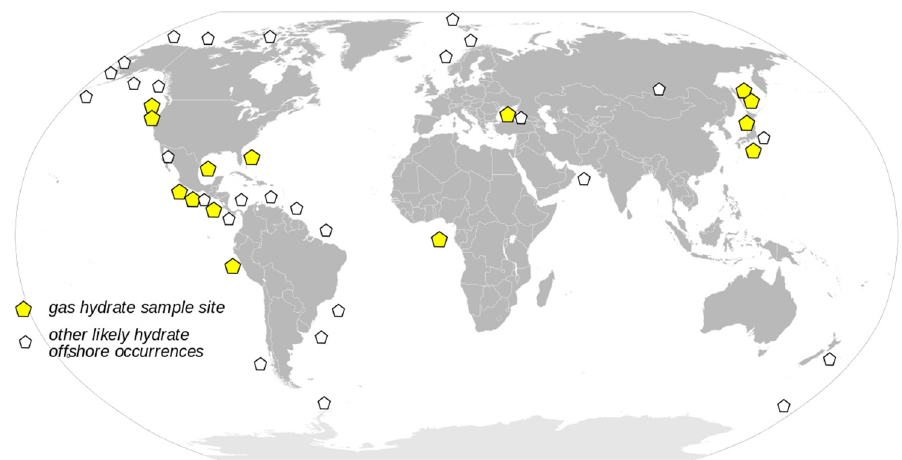
Figure 1. Location of methane hydrate reserves, natural gas hydrate deposits may become an important unconventional natural gas source similar to shale gas. Image from U.S. Geological Survey [16].